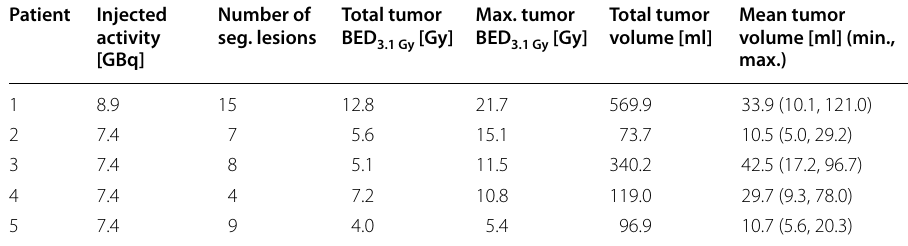
Table 1 Summary of the evaluated patient data. The total tumor BED was calculated for all segmented lesions per patient using the mono-exponential fit model and all available data points (days 1, 2, 3 and